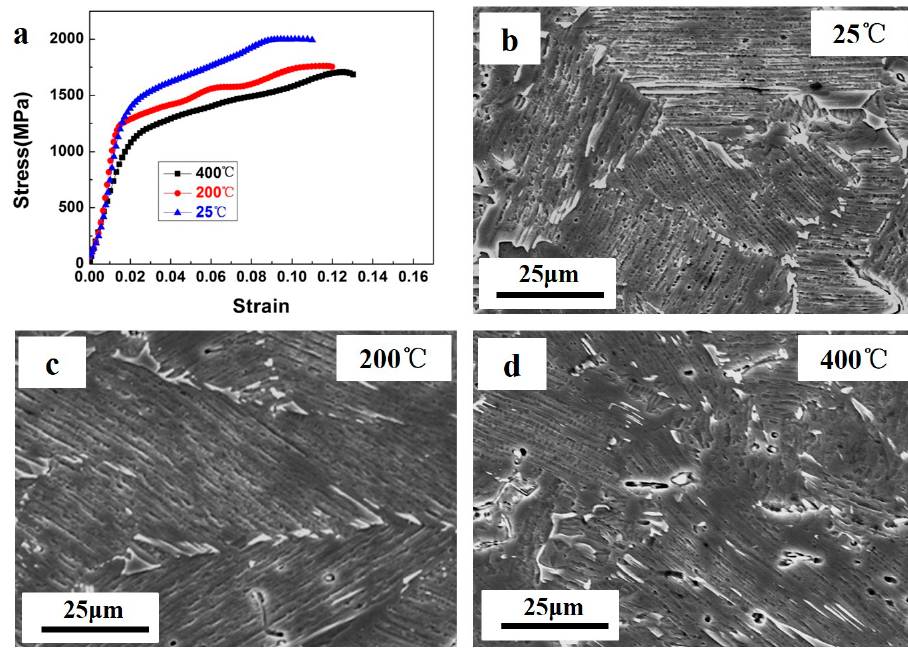
Figure 3. ( a ) The true stress ‐ strain curves of TNM alloy under dynamic compression at different temperatures. SEM images of the deformed TNM alloy with a strain rate of 2000 s –1 at ( b ) 25 °C; ( c ) 200 °C; ( d ) 400 °C.